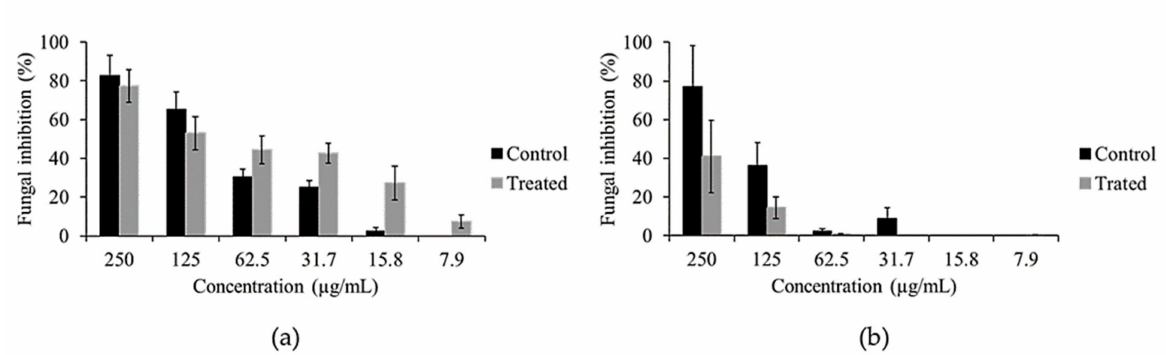
Figure 7. Antifungal activity comparison of mycelium and liquid medium ethyl acetate extracts of 11(2) with and without feeding with methanol extract of Alstonia scholaris against Fusarium oxysporum . ( a ), Antifungal activity of the ethyl acetate extracts of mycelium of 11(2) fed with Alstonia scholaris metabolites (Treated) and without feeding (control). ( b ), Antifungal activity of the ethyl acteate extracts of liquid medium of 11(2) fed with Alstonia scholaris metabolites (Treated) and without feeding (Control). The values represent the average of the antifungal activity ( n = 4), and the bars represent the standard